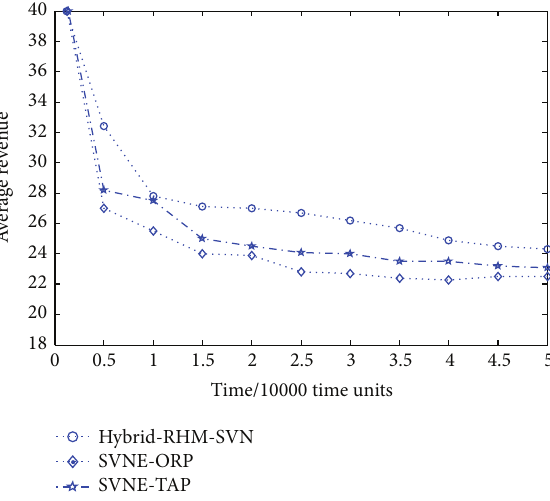
Figure 1: Acceptance rate of virtual network requests.